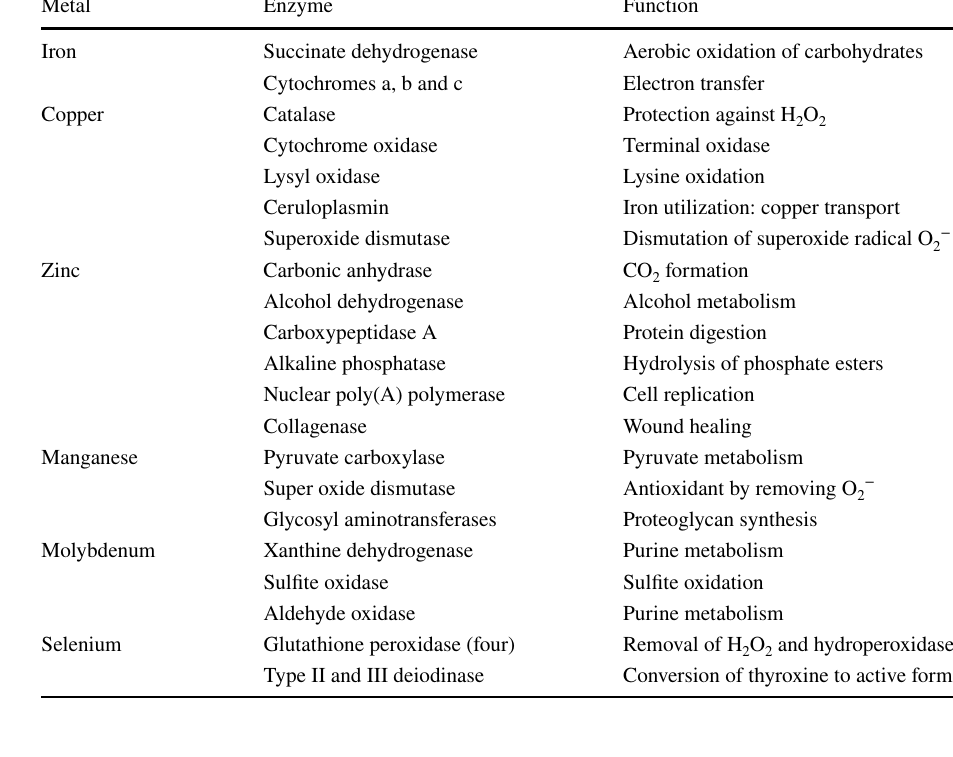
Table 8 Pathophysiology of mineral-responsive diseases in dairy cattle (adopted from Underwood and Suttle